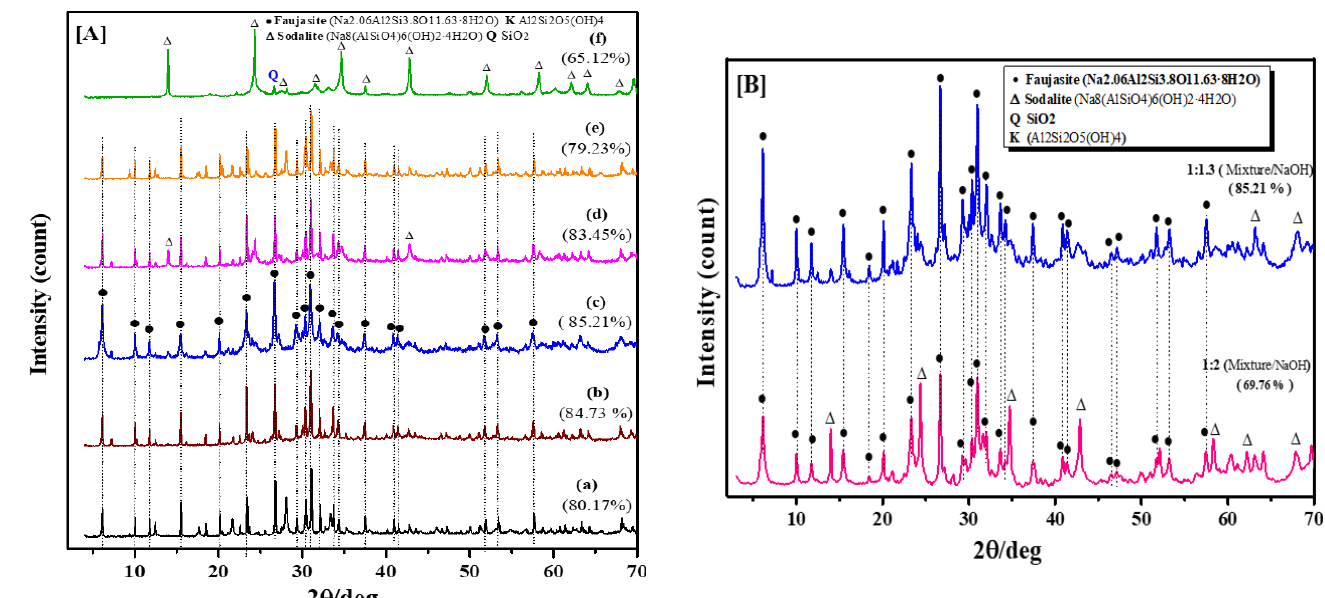
Figure 2. XRD Patterns of synthesized zeolite produced from mixture of SASR-Kaolin at weight ratios of (a) 1:0, (b) 1:2, (c) 1:1.5, (d) 1:1, (e) 2:1, and (f) 0:1 ( A ), XRD Patterns of synthesized products with different mass ratio of mixture-NaOH of 1:1.3 and 1:2 ( B ), where ●: Faujasite, Q: quartz, ∆ : Sodalite zeolite, and K: Al 2 Si 2 O 5 (OH) 4 .